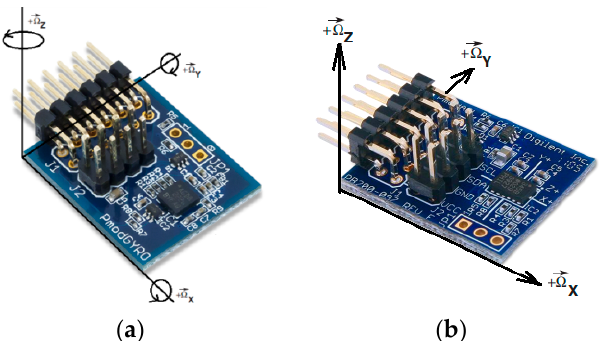
Figure 1. Inertial sensors: ( a ) gyroscope L3G4200D; ( b ) accelerometer ADXL345. Measured range: one of the available value ranges, e.g., ±250 dps, or °/s (grad/s). The sensitivity value is 0.00875°/LSB (LSB—least significant bit).